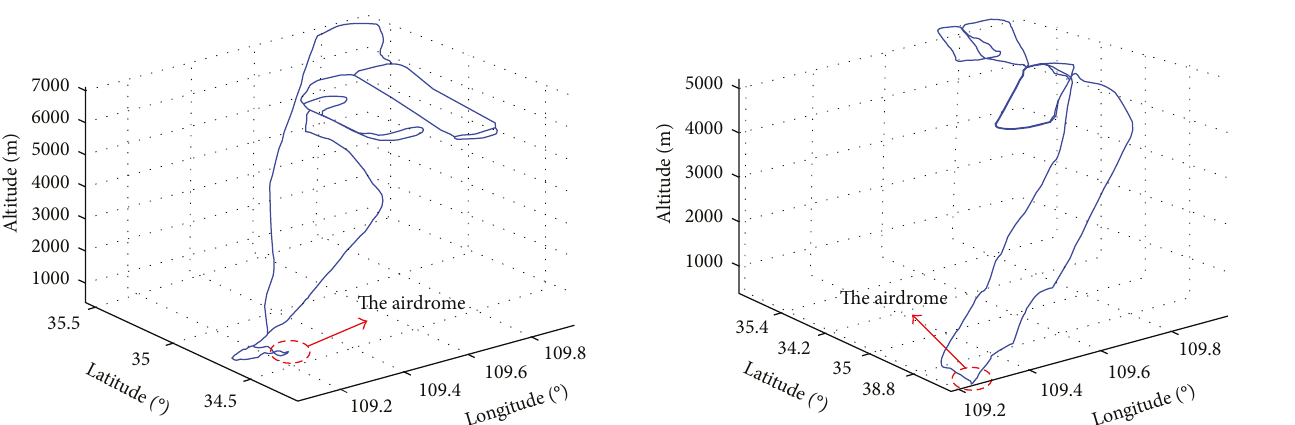
Figure 5: The fl ight trajectory of the experiment in Shaanxi Province, China, in March